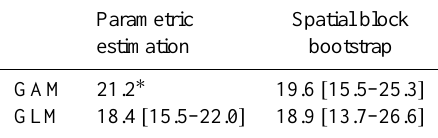
Table 2. Estimated odds ratios and their 95% confidence intervals for landslide occurrence distant from roads (200m distance) versus near the road (25m distance) using the GAM and GLM. Estimation based on the spatial block bootstrap and the standard parametric